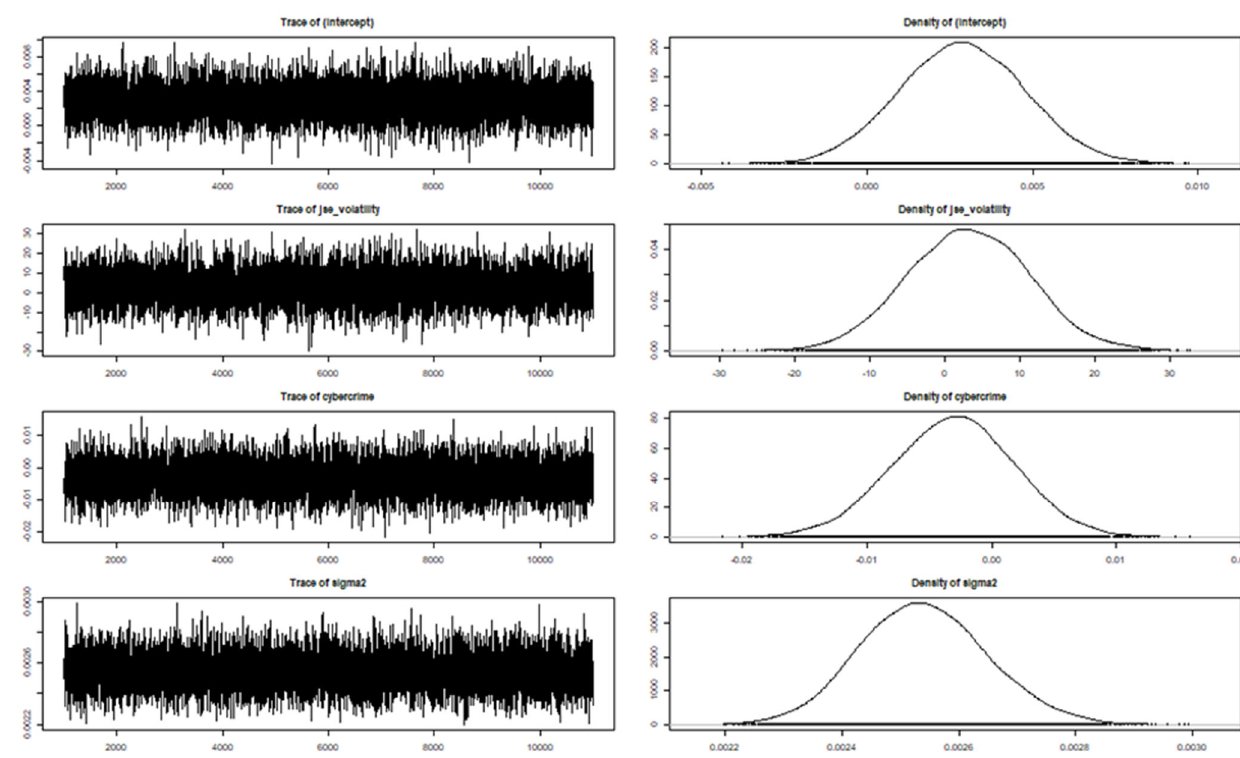
Figure 9. Posterior distribution of the variables with return on Ethereum as dependent variable.